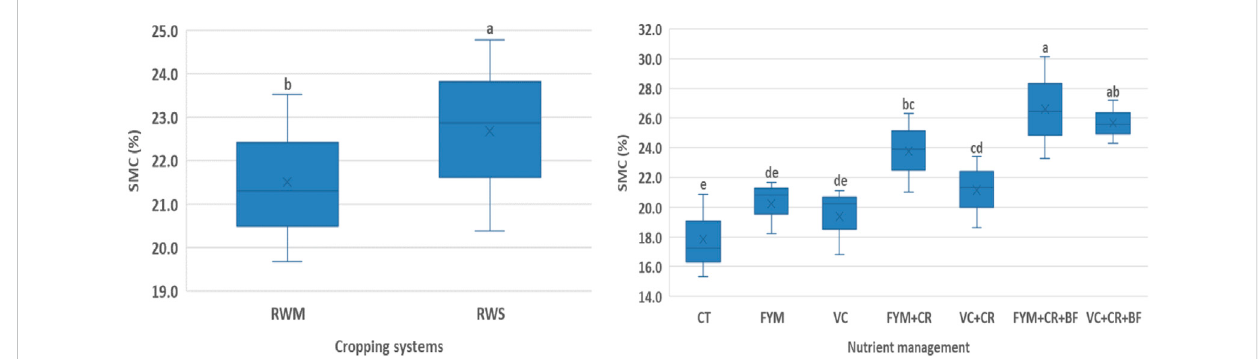
FIGURE 6 Long-term effectofcroppingsystemsandorganicnutrientmanagementonSMC.SMC:soilmoisturecontent;RWM:rice-wheat-mungbean;RWS: rice-wheat-sesbania; CT: control; FYM: farm yard manure; VC: vermicompost; CR: crop residue(s); and BF: biofertilizer(s). Statistical method: analysis of variance for strip-plot design in SAS 9.3 software; n = 42. Values with a different capital letter indicate a signi fi cant difference among the different treatments at p < 0.05 by the LSD test. Bars represent means ± SEM.